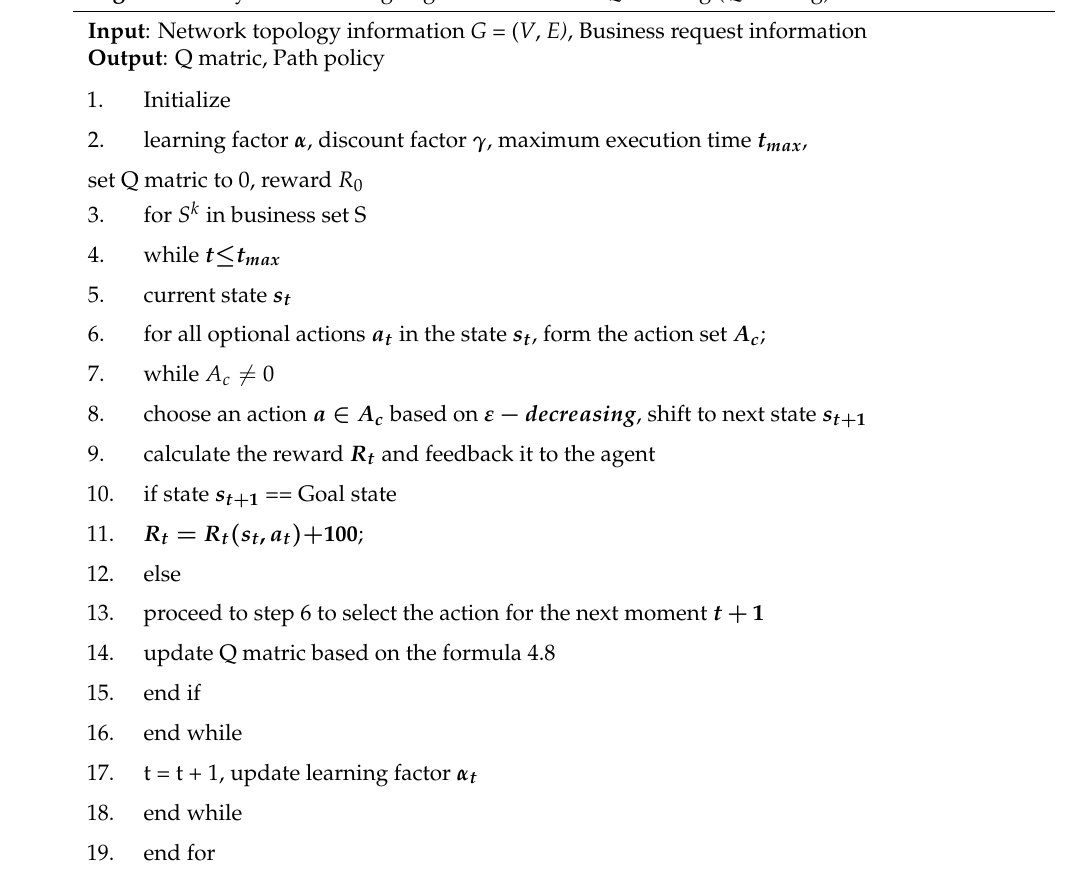
Algorithm 1 Dynamic Routing Algorithm Based on Q-learning